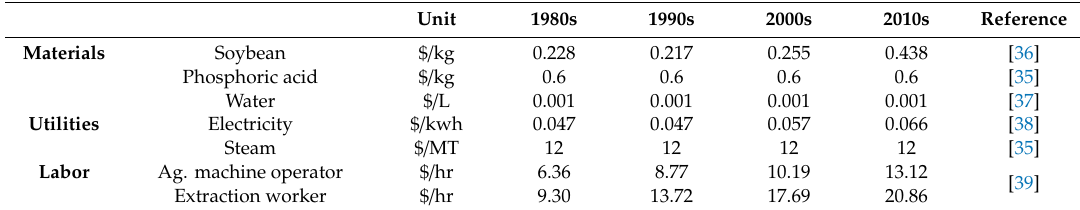
Table 3. Operating cost inputs for TEA